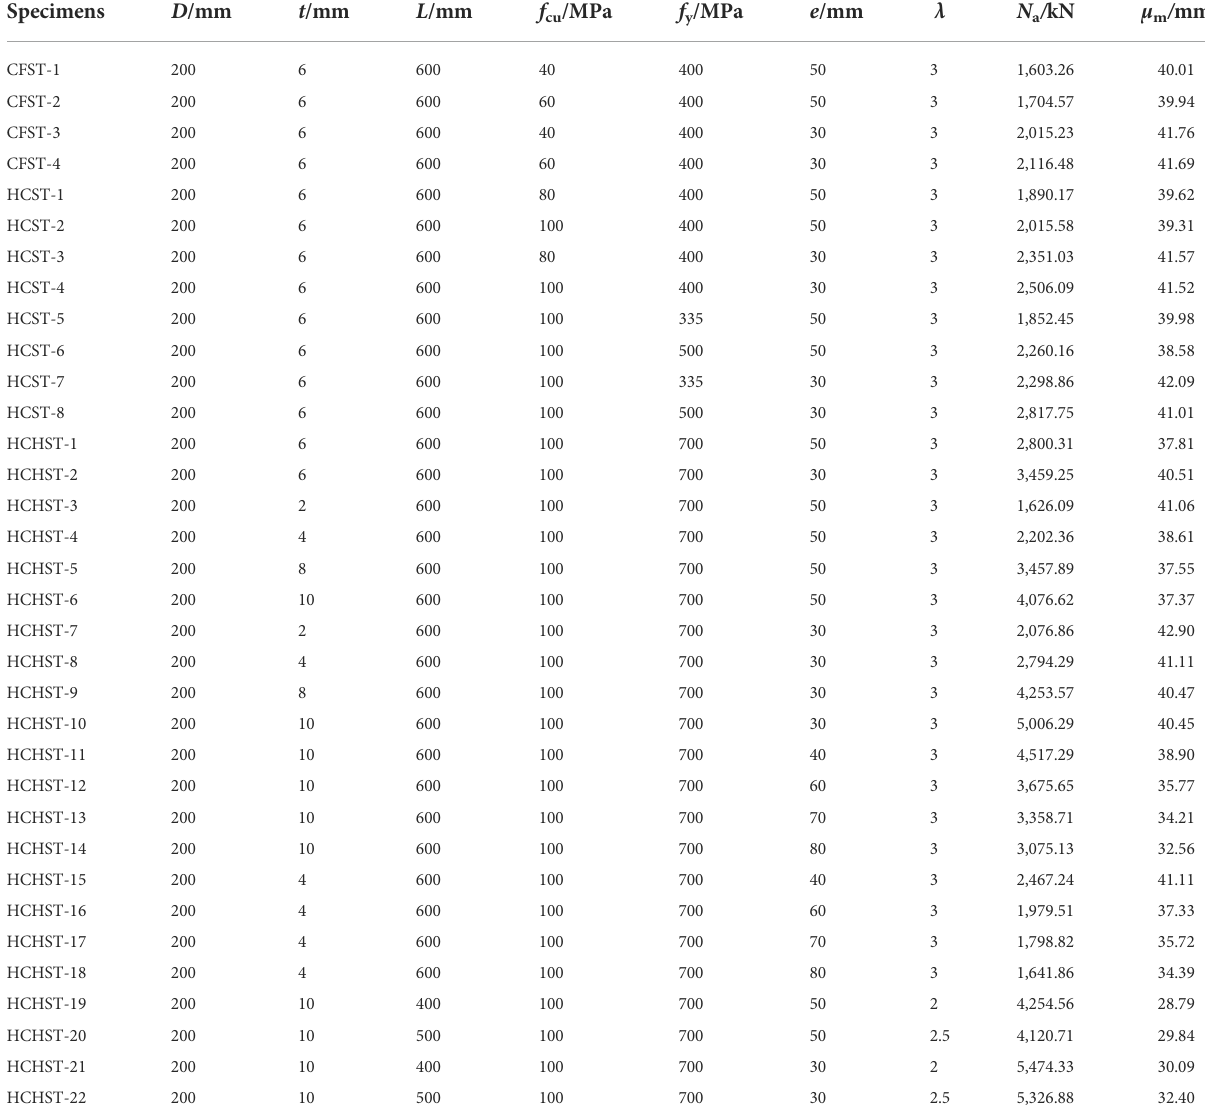
TABLE 3 The ultimate eccentrical compression bearing capacity and mid-span lateral de fl ection of 34 specimens.